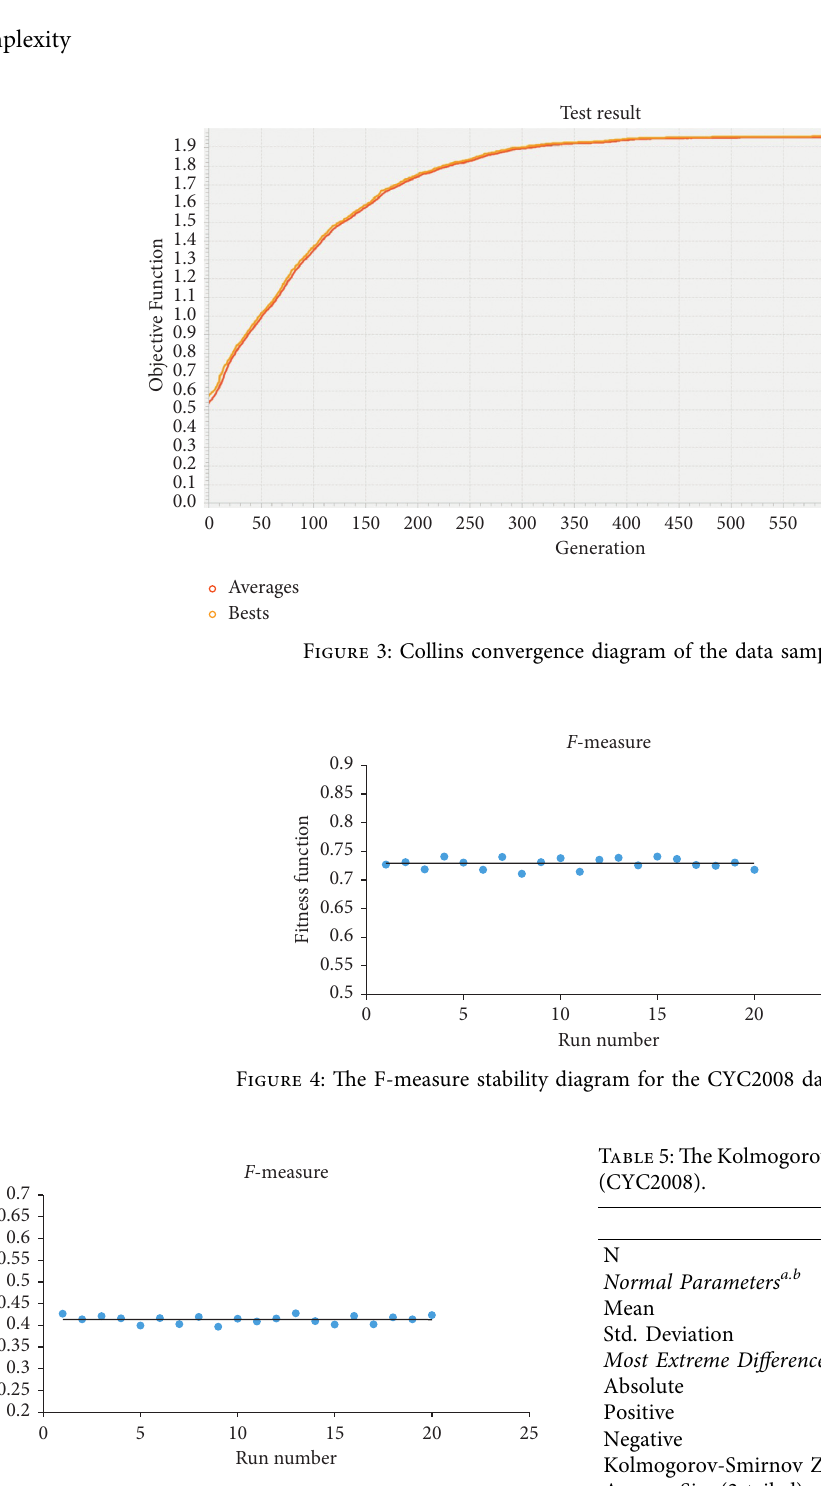
Figure 5: The F-measure stability diagram for the MIPS data sample.